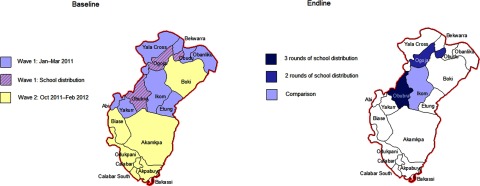
Maps of Baseline and Endline Survey Strata by Mode of ITN Distribution per LGA, Cross River State, NigeriaAbbreviations: ITN, insecticide-treated net; LGA, local government area.